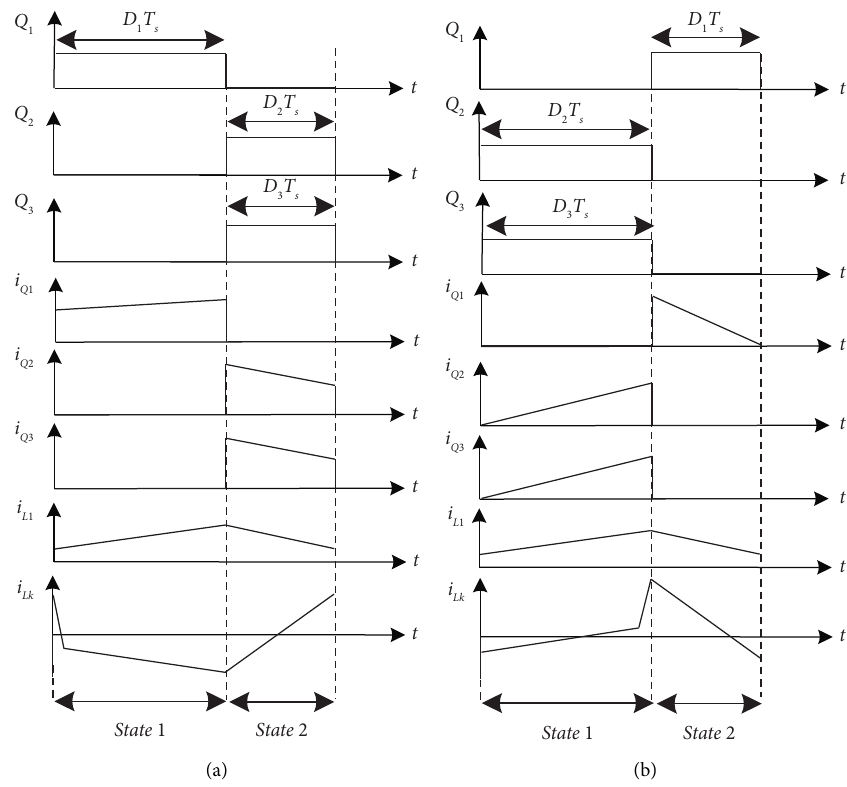
Figure 2: Te main waveforms: (a) step-up mode and (b) step-down mode.